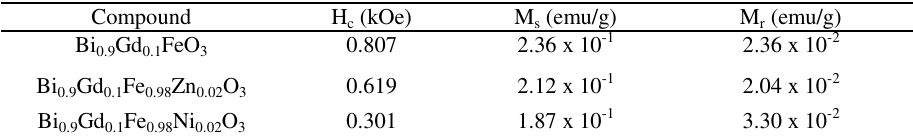
Table 4. Some magnetic parameters of the Gd-doped BiFeO